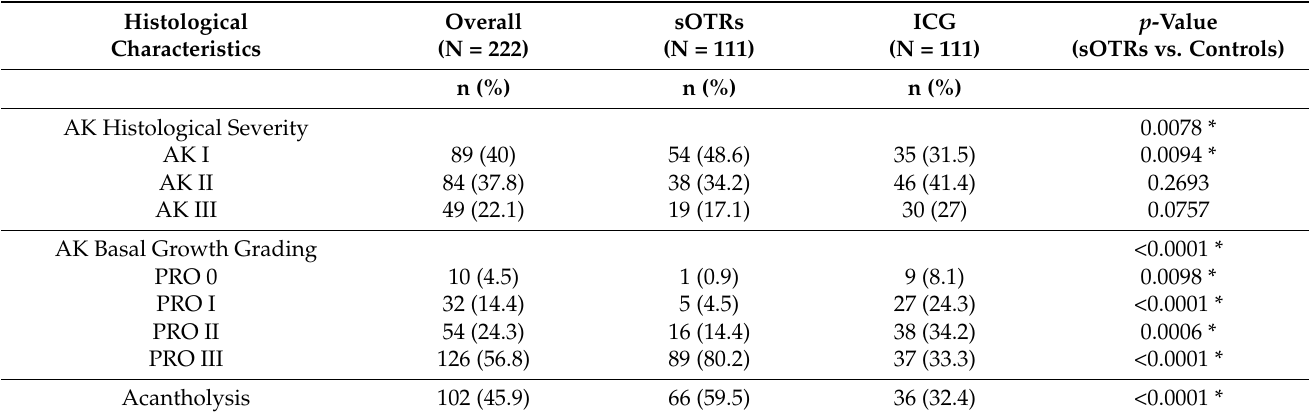
Table 2. Histological characteristics of actinic keratoses (AKs) from solid organ transplant recipients (sOTRs) and matched immunocompetent control group